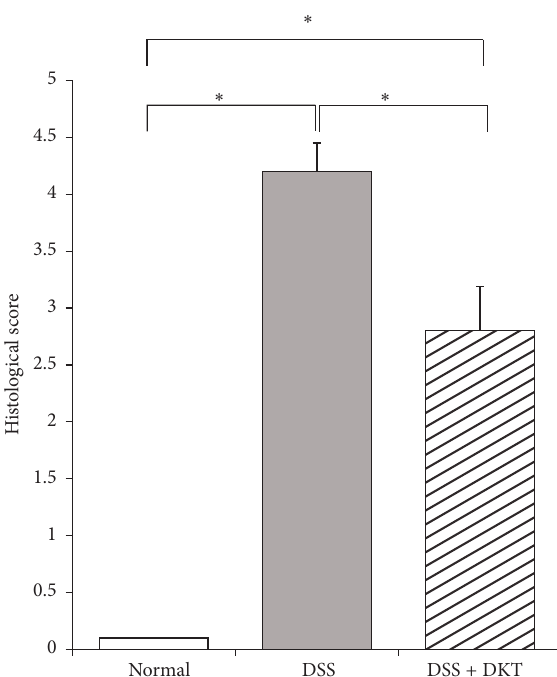
Figure 5: Histological score of each study group. Normal group, untreated mice. Dextran sulfate sodium (DSS) group, mice provided with 5% DSS for 7 days. DSS + daikenchuto (DKT) group, mice provided with DKT in addition to DSS. 𝑛 = 10 mice (for normal, DSS, and DSS + DKT groups). ∗ 𝑝 < 0.05 .